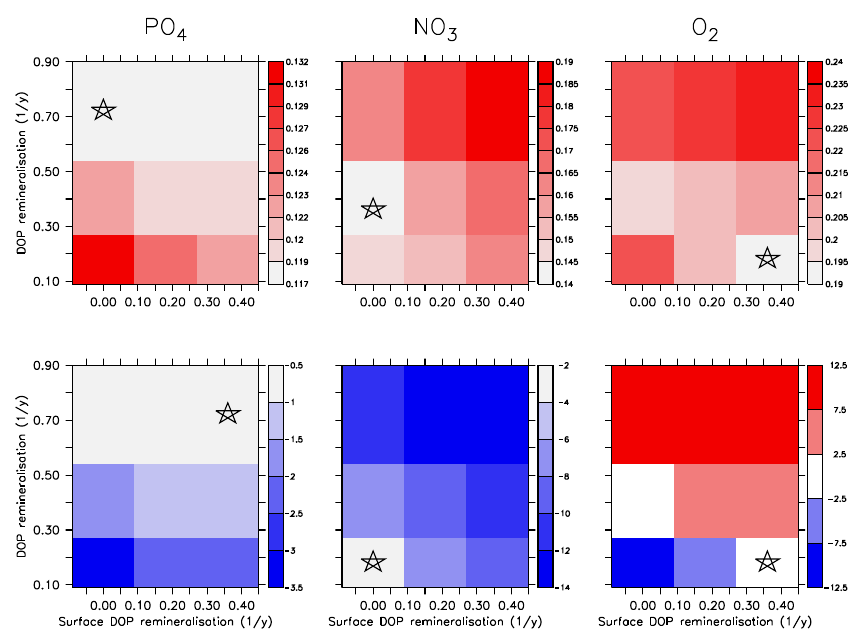
Figure 6. Components of the misfit function ( J(j ) of Eq. 11; upper panels) and model bias (lower panels), projected onto λ s and λ . Bias is expressed as (m j /o j − 1 ) × 100, where m j is the global average model tracer, and o j the average observed tracer, for the three tracers phosphate ( j = 1; left panels), nitrate ( j = 2; mid panels) and oxygen ( j = 3; right panels). An open star indicates the respective lowest misfit or bias.